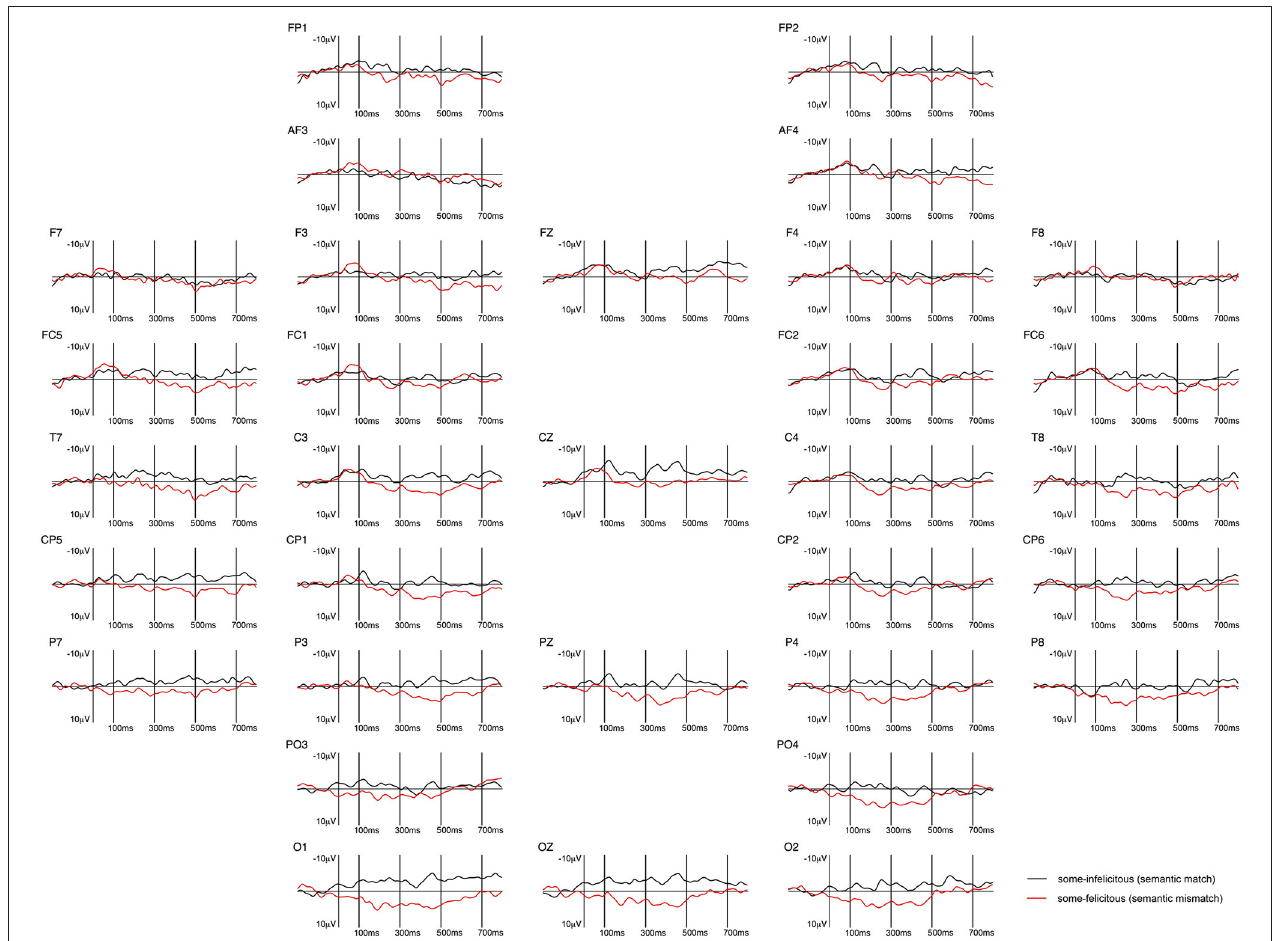
FIGURE 1 | Grand-averaged ERPs recorded in children, time-locked to the presentation of the word “Alle” ( all ) for the some -infelicitous condition (black line) compared to the some -felicitous condition (red line).